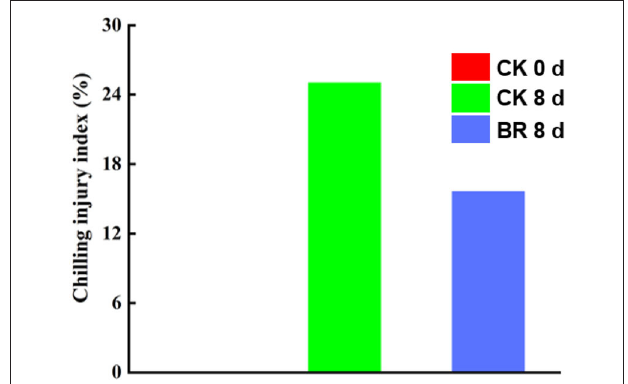
FIGURE 2 | Overview of differentially expressed metabolites. (A) Cluster analysis of differentially expressed metabolites s of CK 8- and 0-day group. (B) Classification of differential metabolites and their proportion in total differential metabolites of CK 8 d and 0 d groups. (C) KEGG pathway analysis of differential metabolites of CK 8- and 0-day group. (D) Correlation analysis of differential metabolites of CK 8- and 0-day group.